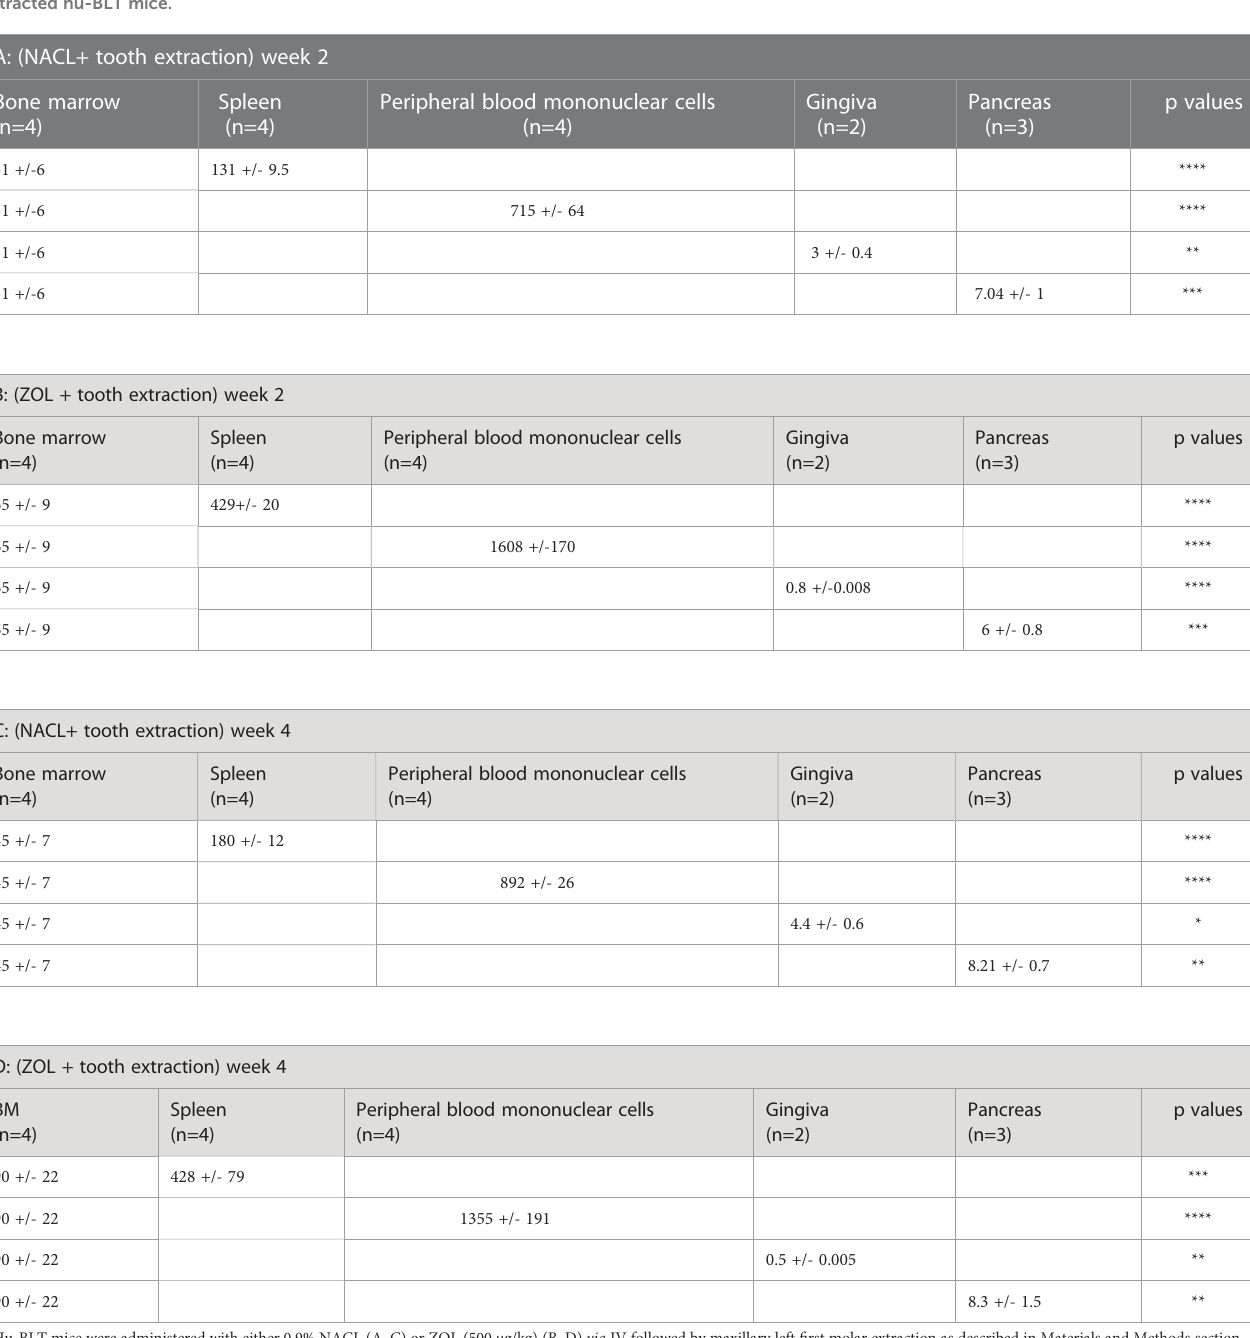
TABLE 4 IFN- g secreted by splenocytes, PBMCs, gingiva, and pancreas was compared to IFN- g secreted by BM of NACL and ZOL-injected and tooth- extracted hu-BLT